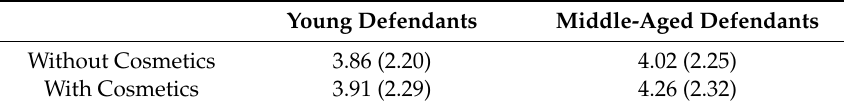
Table 2. Means and standard deviations for sentencing